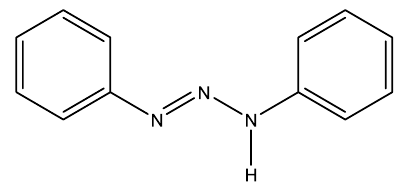
Figure 1. Structure of 1,3- bis (phenyl)triazene.